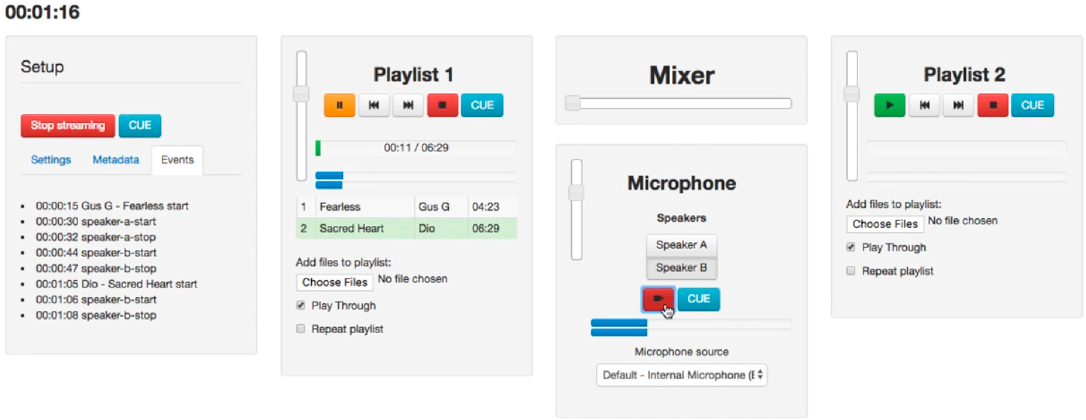
Figure 3. Information 2020 , 11 , x FOR PEER REVIEW